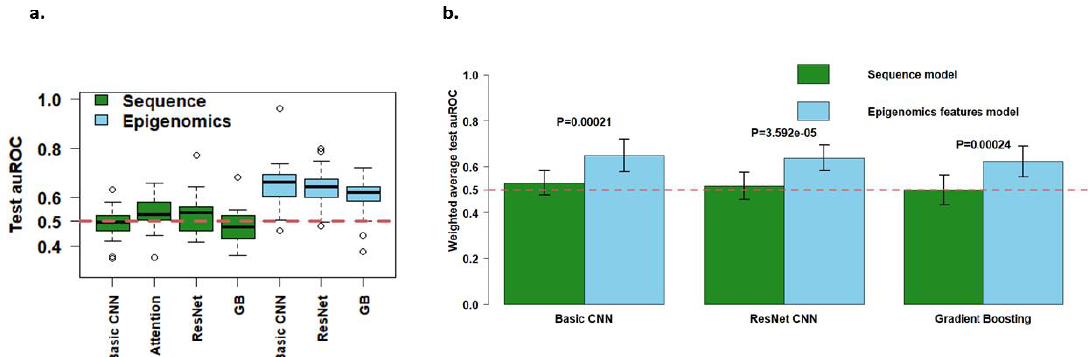
Figure 5. Comparison on the weighted average Area Under Receiver Operating Characteristic (AUROC) between the sequence and epigenomics models. ( a ) Boxplot of test AUROCs for all sequence and epigenomic models across 21 chromosomes; ( b ) Mean test AUROC comparison between the sequence and epigenomics models. The bars are ±1 weighted standard deviation around the weighted mean AUROC. p values are from the paired t -test with 𝐻 0 : The test AUROCs are the same for the sequence and epigenomics models. p values are not adjusted for multiple comparison but remained significant after the Bonferroni adjustment.